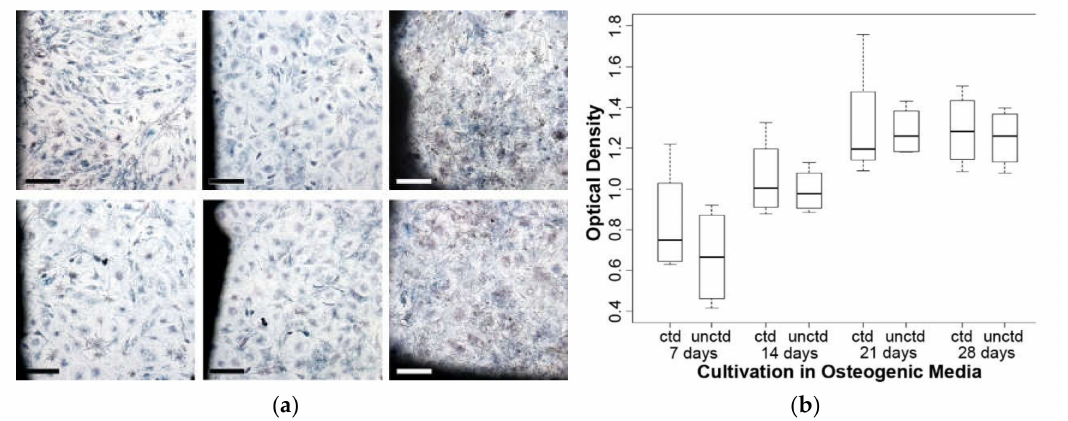
Figure 3. MTT: The pictures ( a ) were taken before measuring optical density to illustrate the distribution of the cells and the position in close proximity to the metal on the left side. Top row: coated, 7, 14, and 28 days. Bottom row: uncoated, 7, 14, and 28 days; bar = 200 µ m ( b ) There is no significant di ff erence between the mitochondrial activity of the cells in the presence of the coated (ctd) and uncoated (unctd) material.